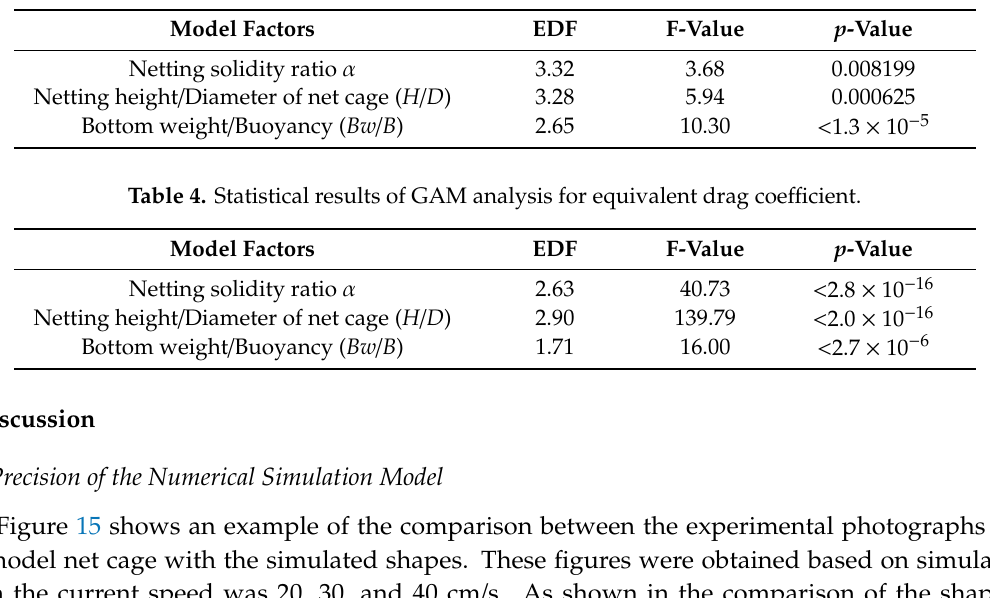
Figure 16. Comparison of drag force and cage volume between the experimental and simulation results as a function of current speed ( α = 0.12, H = 0.42 m, Bw = 476.5 g). ( a ) the drag force; ( b ) the cage volume.